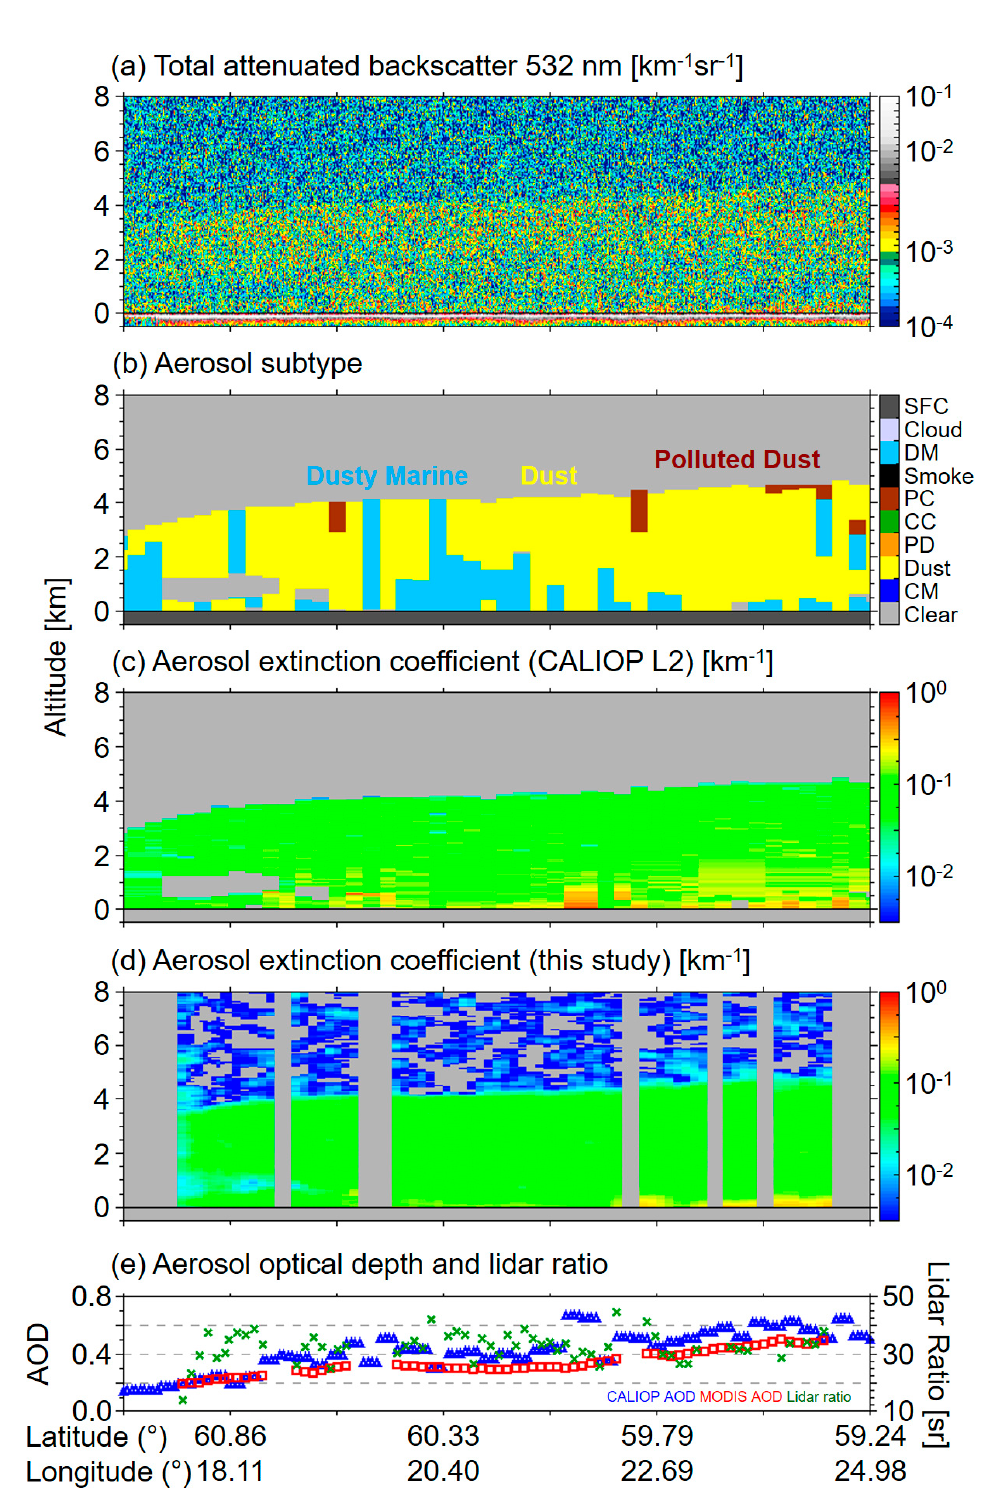
Figure 2. Cloud-Aerosol Lidar with Orthogonal Polarization (CALIOP) measurements of ( a ) total attenuated backscatter at 532 nm, ( b ) aerosol subtypes, ( c ) aerosol extinction from the CALIOP level 2 profile product, ( d ) aerosol extinction retrieved in this study, ( e ) aerosol optical depths from CALIOP level 2 product (blue triangles) and MODIS level 2 aerosol product (red squares) and lidar ratios retrieved in this study (green x-marks) over the Arabian sea in 18 October 2009 from 09:32:59 UTC to 09:34:50 UTC.